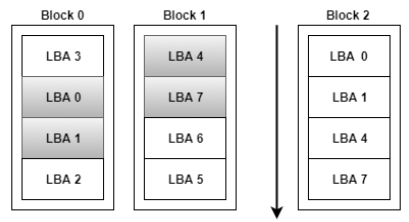
Figure 1.1. Write pattern (0-1-4-7) is applied, and as the result, some data become invalid in Block 0 and